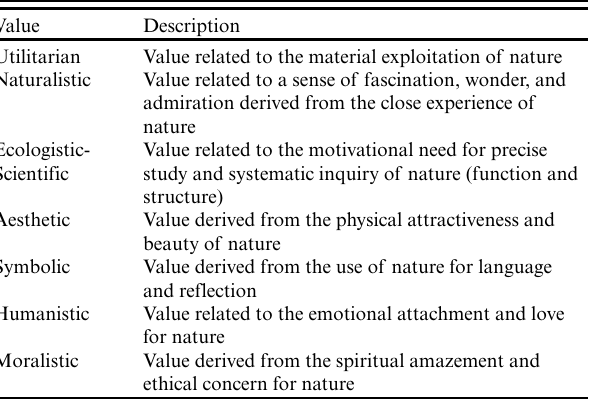
Table 1 . Human values toward nature (Adapted from Kellert